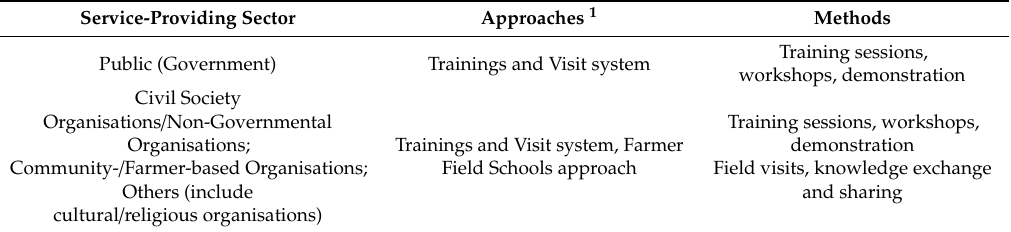
Table 6. Existing Advisory Extension Service Approaches and Methods identified in the Case Study Locations—Questionnaire Survey / Focus Group Discussion and